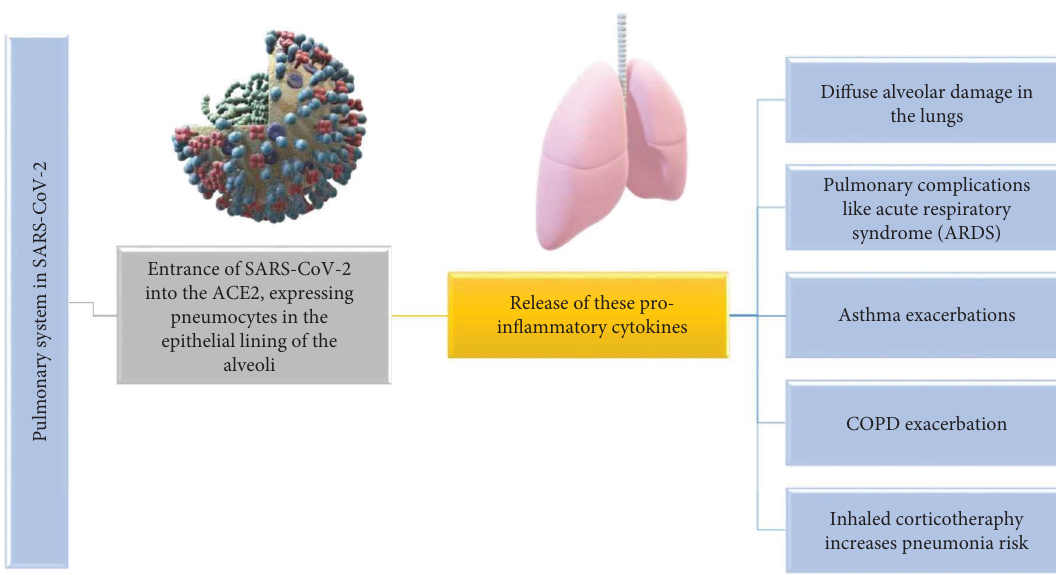
Figure 4: Relevant aspects of the viral infection in respiratory